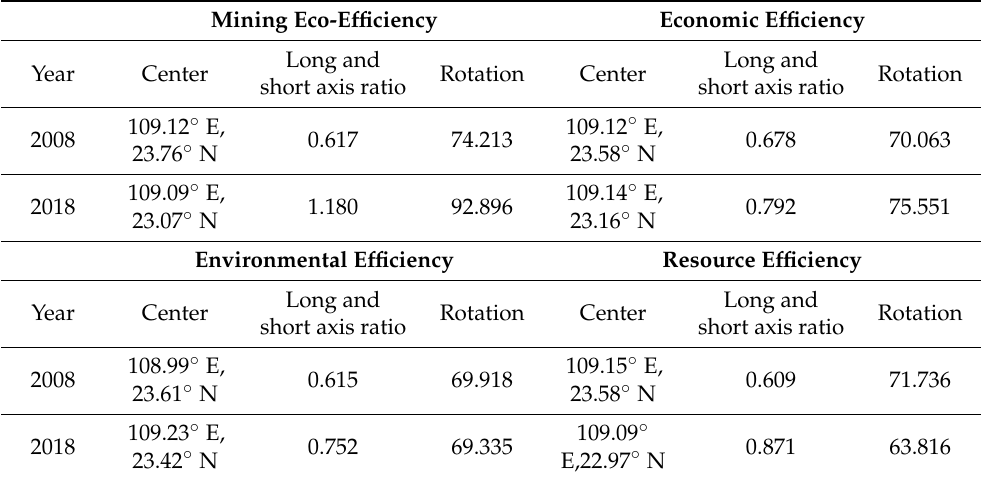
Table 4. Changes of elliptical parameters of standard deviation from 2008 to